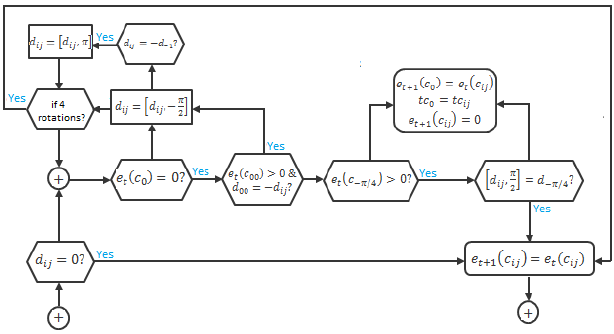
Figure 2. Diagram of the technicians displacement function dep ( c ij )